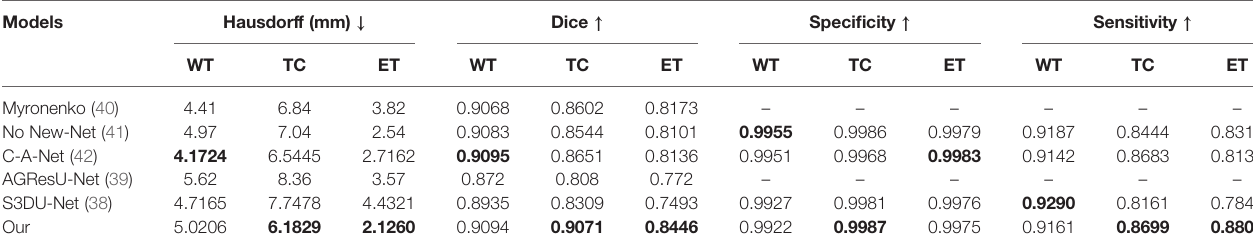
TABLE 2 | Comparison of performance between our approach and the state-of-the-art methods on BraTS 2018 validation set using Dice, Hausdorff distance, speci fi city, and sensitivity metrics. Models